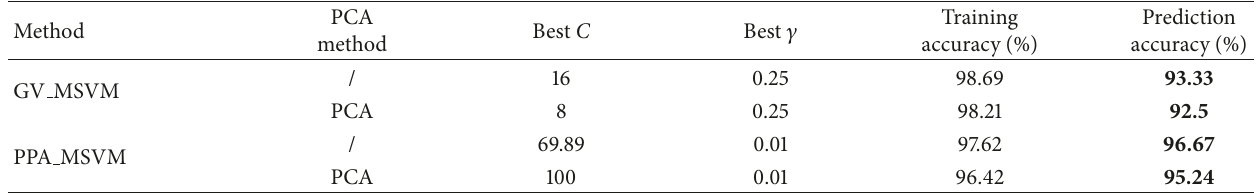
Table 5: Comparison of the performance of PPA MSVM with GV MSVM classifiers.